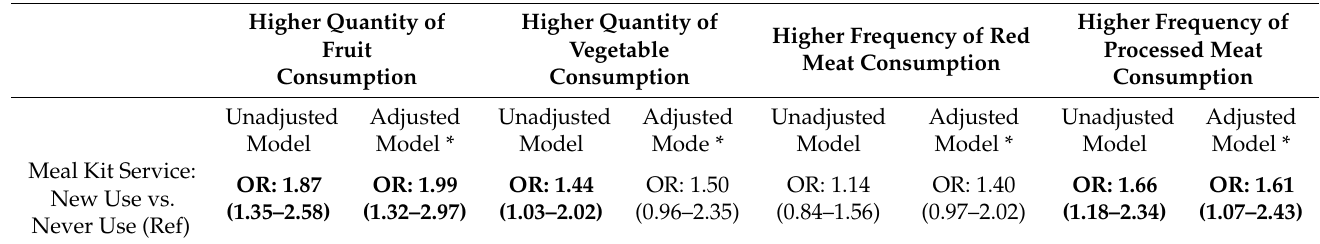
Table 4. Associations of Reported Quantity of Foods Consumed and New Use of Meal Kit Delivery Services during the Early Months of COVID-19 Pandemic: Results from the National Food Access and COVID Research